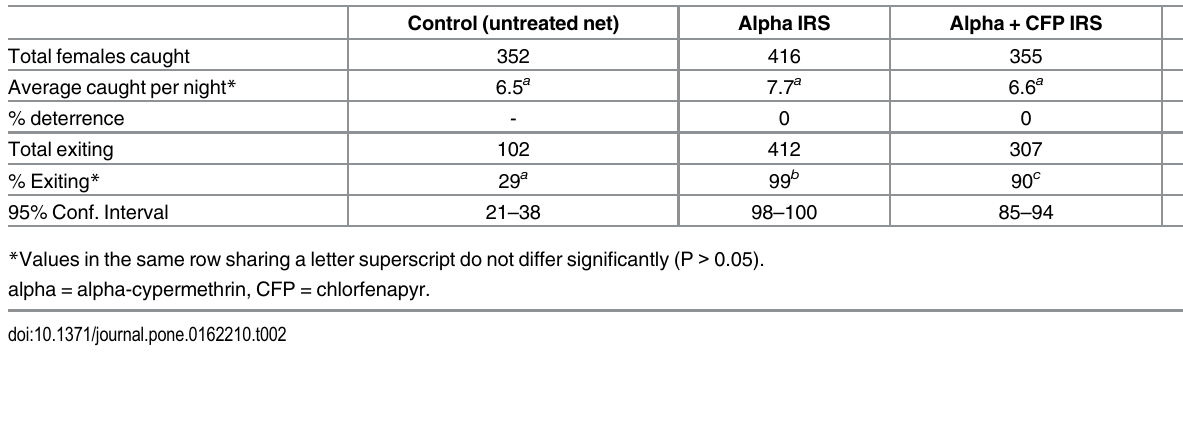
Table 2. Entry and exiting rates of wild pyrethroid resistant An gambiae sl in experimental huts in Cove,